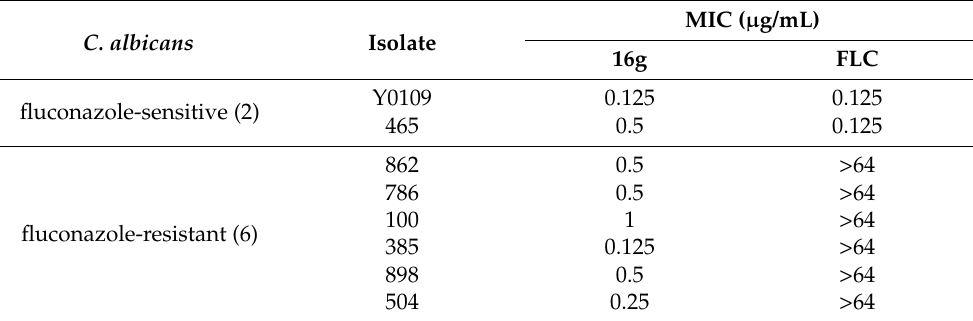
Table 3. In vitro antifungal activities against drug-resistant C. albicans of 16g and FLC.